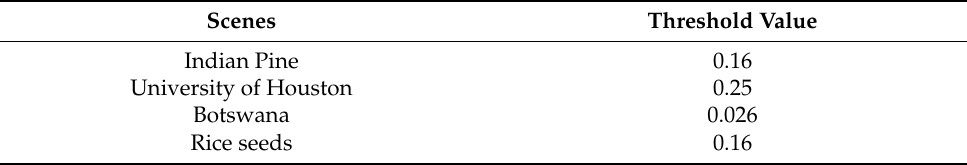
Figure 1. Scheme of neighbors selection using a variance radius. Table 1. Threshold values for selecting neighborhood pixels for each